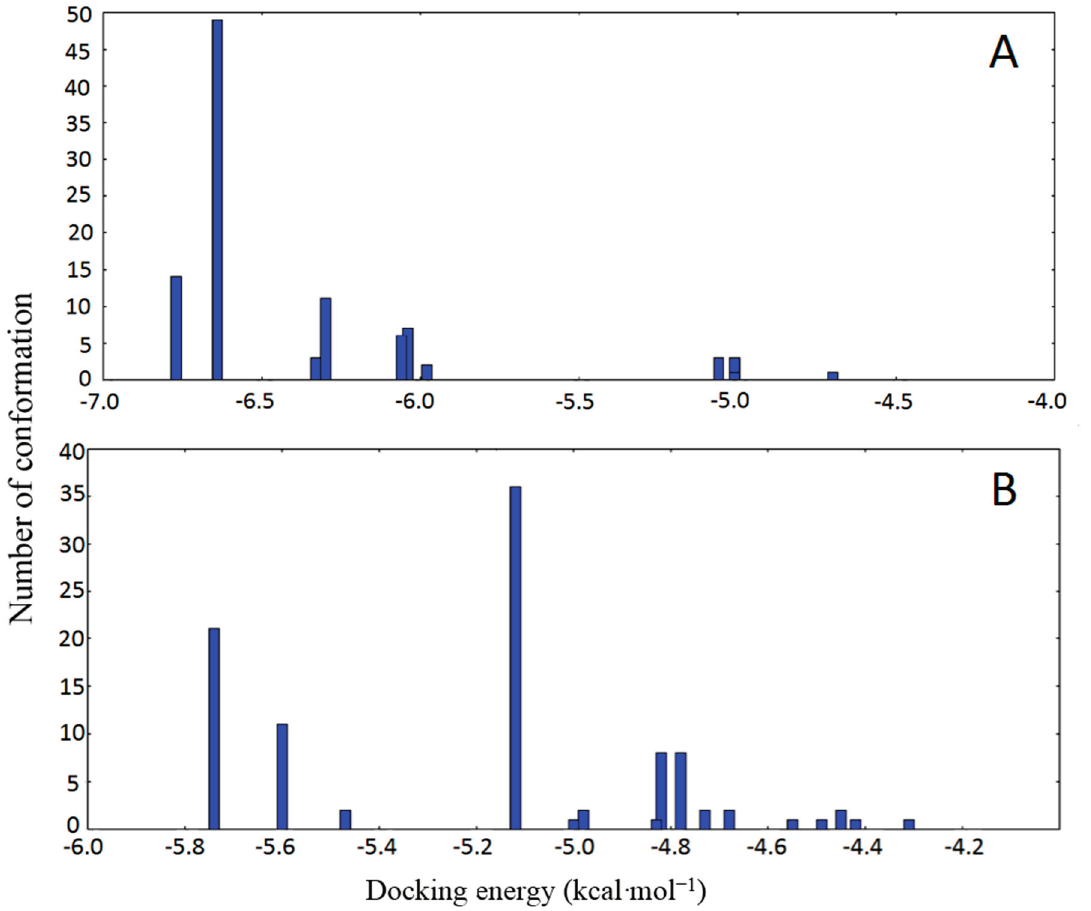
Figure 6. Cluster analyses of the AutoDock docking runs of curcumenone in the drug binding site I ( A ) and site II ( B ) of HSA